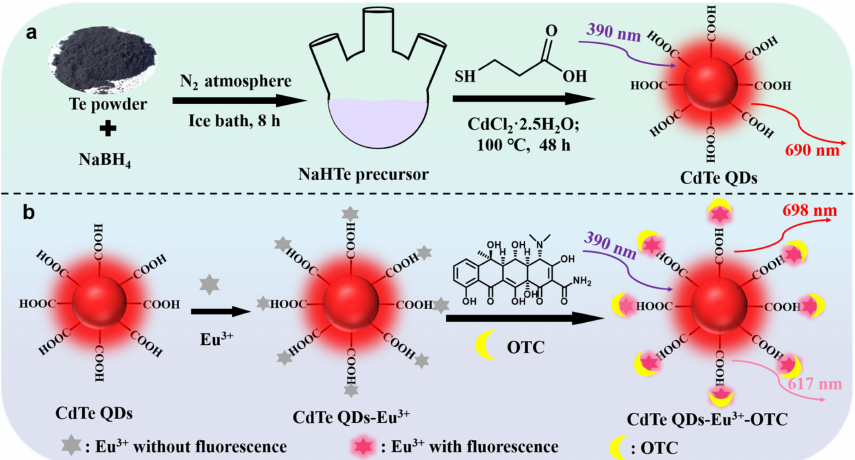
Figure 1. ( a ) Synthetic route of CdTe QDs. ( b ) Construction of ratiometric fluorescence probe and its application for OTC